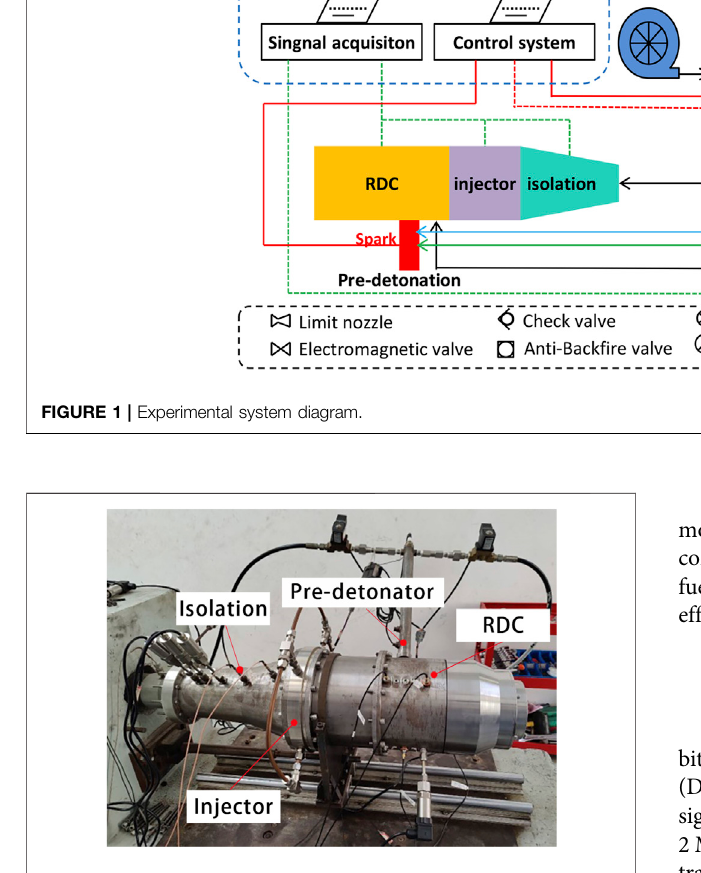
FIGURE 2 | Photograph of the RDC test